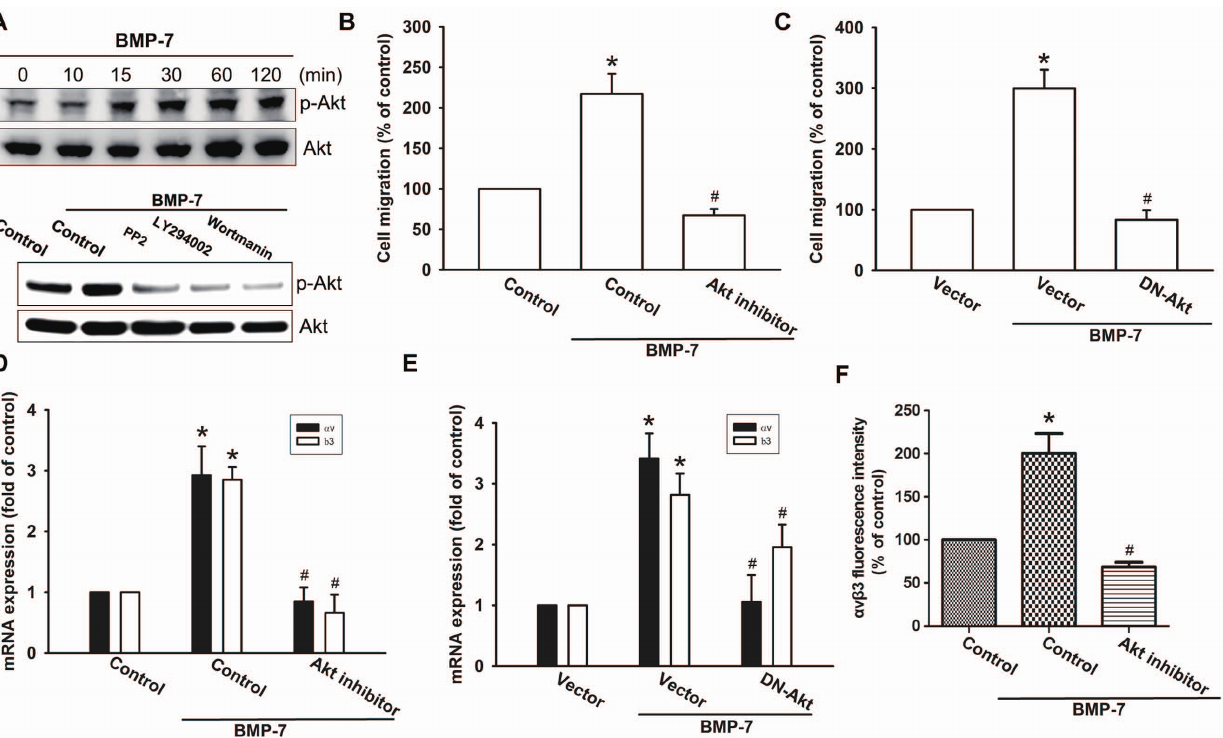
Figure 4. Akt is involved in BMP-7-mediated migration and up-regulation of integrin a v b 3 in human chondrosarcoma cells. (A) JJ012 cells were incubated with BMP-7 for indicated time intervals (upper panel) or pretreated with PP2, Ly294002, or wortmannin for 30 min followed by treatment with BMP-7 for 2 h (lower panel). The levels of p-Akt and Akt were measured by Western blot. Data are representative of at least three independent experiments. (B–E) Cells were pretreated with Akt inhibitor (10 m M) for 30 min or co-transfected with Akt mutant for 24 h, and then incubated with BMP-7 for 24 h. The in vitro migration and integrin a v b 3 expression was measured by Transwell (n=4) and q-PCR (n=4). (F) The effect of Akt inhibitor on BMP-7-induced up-regulation of integrin a v b 3 at protein level was determined by flow cytometry analysis (n=5). Results are expressed as the mean 6 SEM. * p , 0.05, compared to basal expression levels. # p , 0.05, compared to expression levels in the BMP-7-treated group.